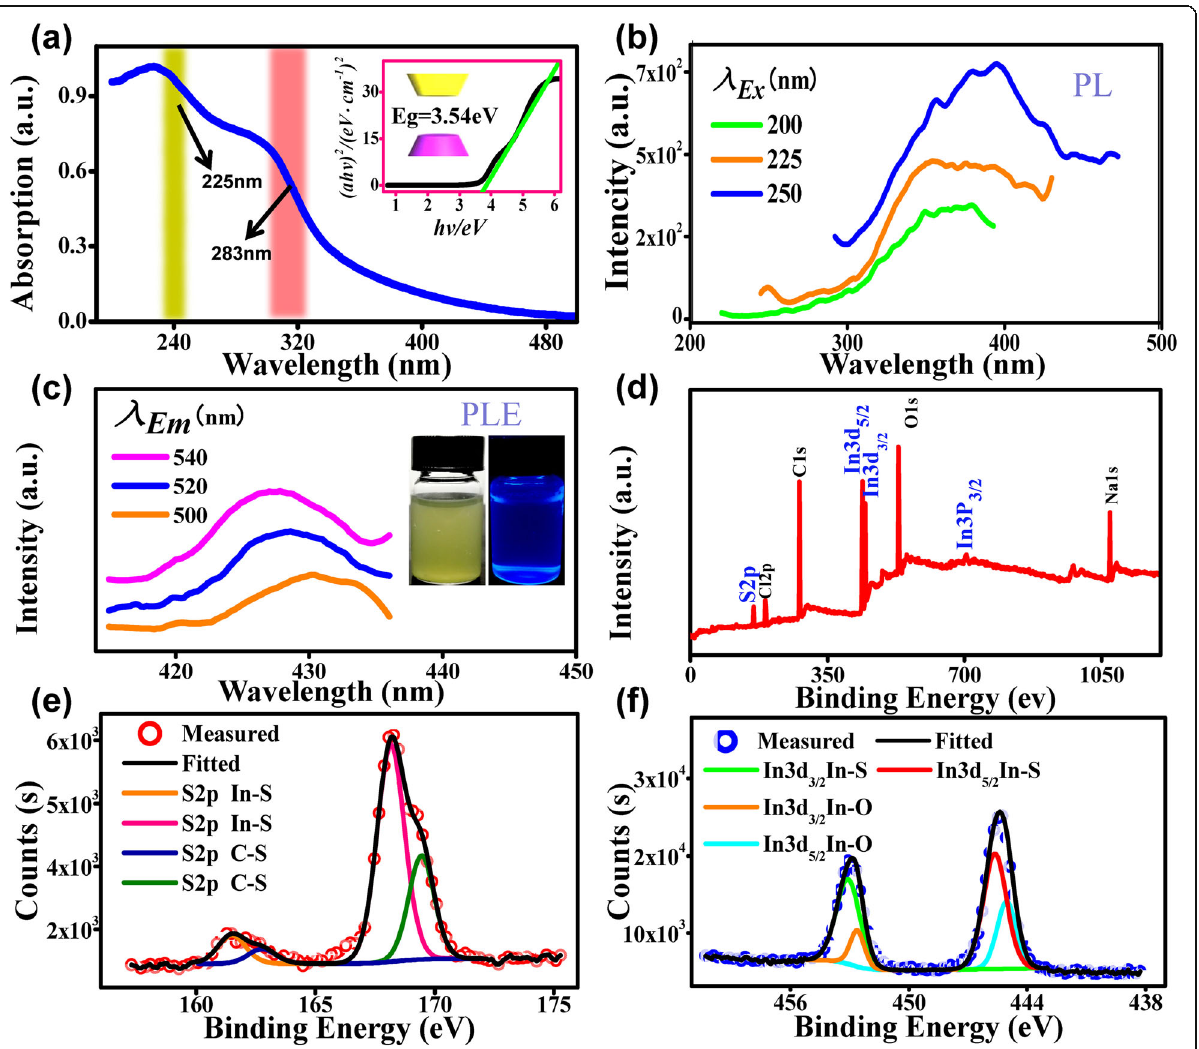
Fig. 2 a UV-vis absorption spectra of In 2 S 3 QDs aqueous solution. Inset: an estimation of band gap energy ( E g ). b PL emission spectra. c PL excitation (PLE) spectra, inset: luminescence image under visible and 365 nm light source. d The XPS full-scan spectrum. e XPS S2p spectrum. f XPS In3d 3/2 and In3d 5/2